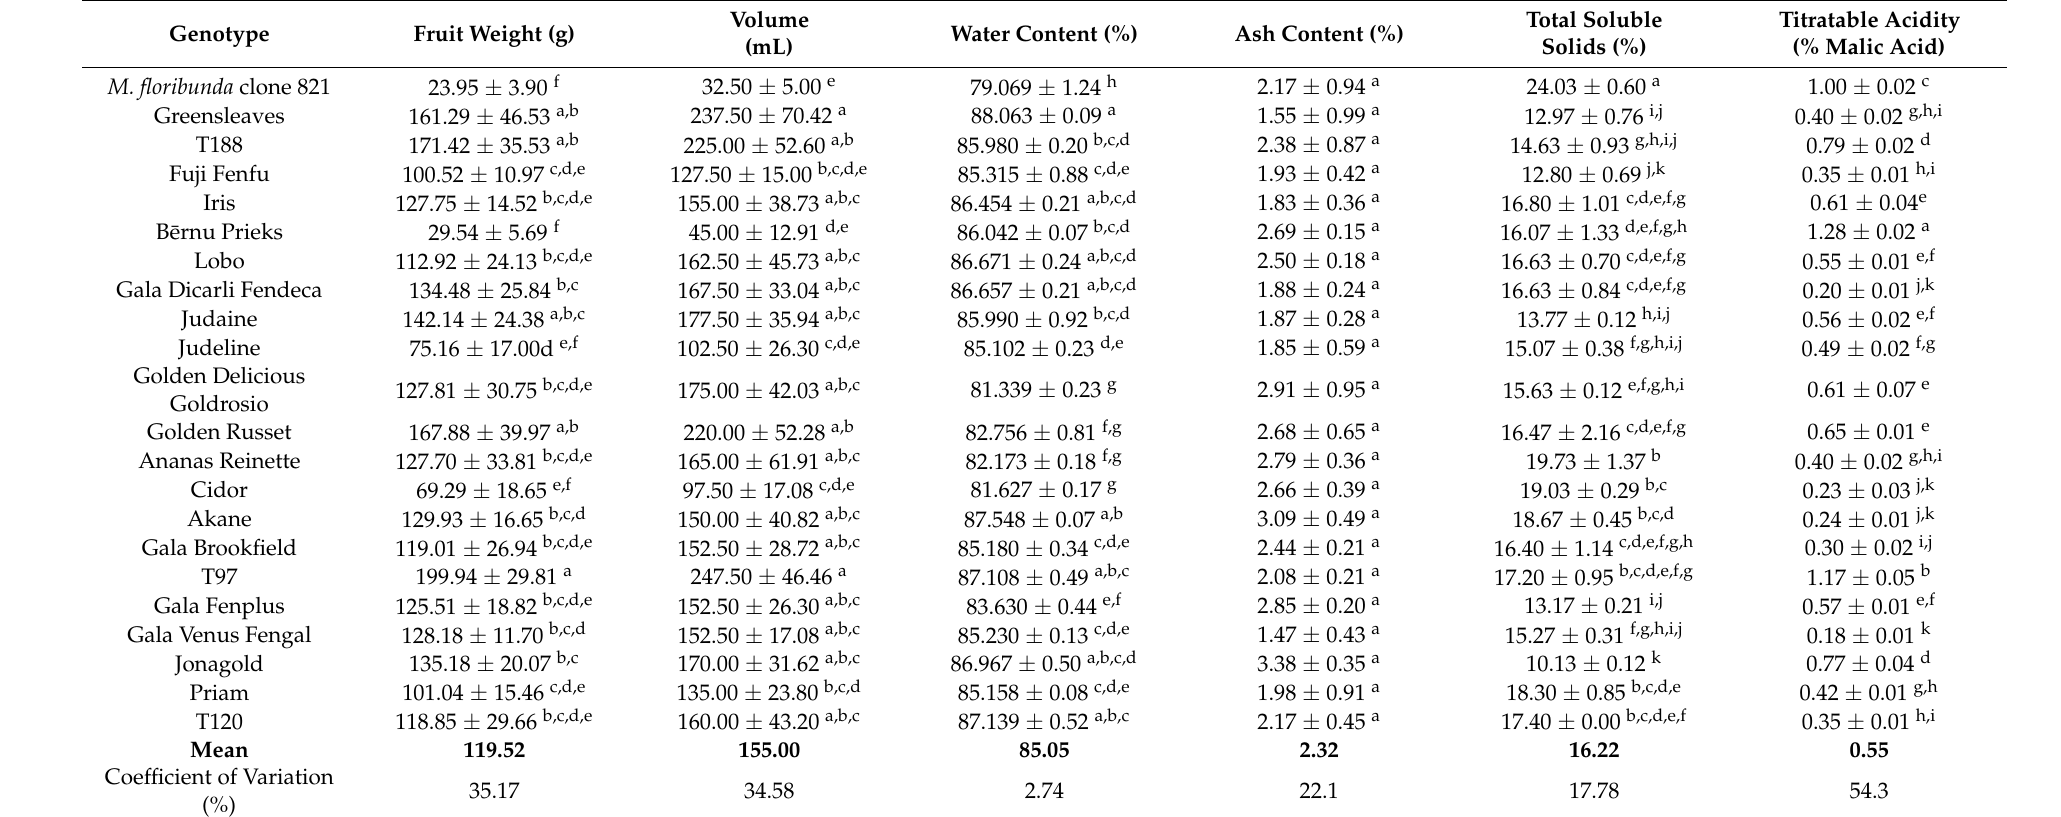
Table 2. Basic physico-chemical properties of 22 apple